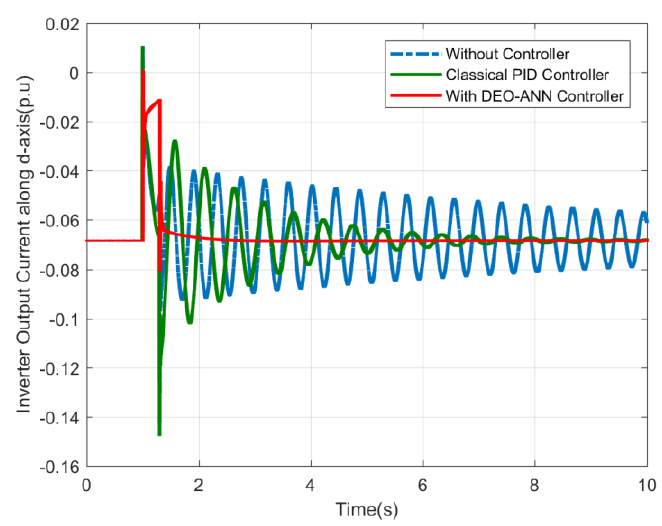
Figure 18. Inverter output current along the d-axis.